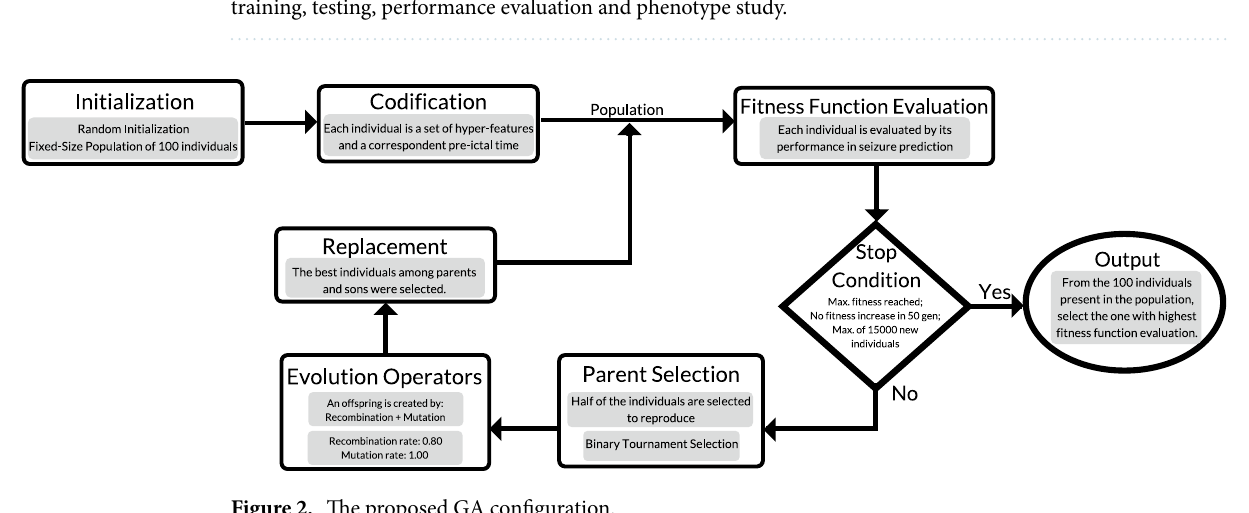
Figure 2. The proposed GA